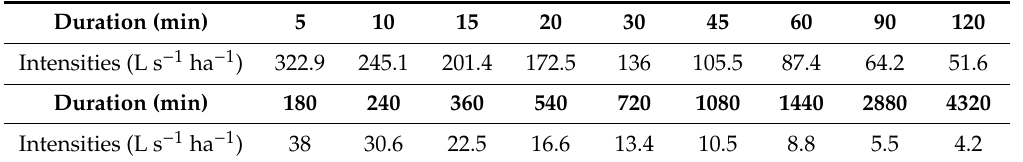
Table 3. Precipitation intensities of di ff erent event durations for an event of statistical recurrence interval of 5 years for the site Schöneck / Vogtland.